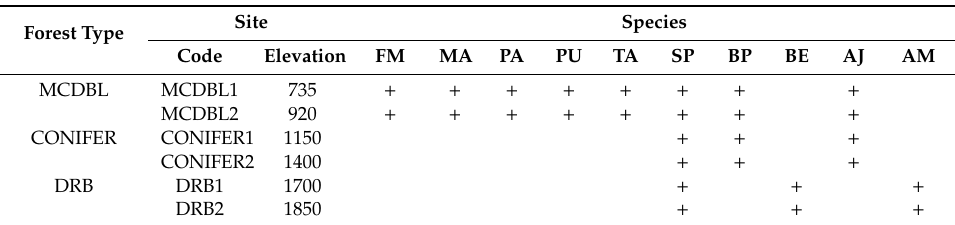
Table 2. The list of six sampling sites distributed in three forest types along the altitudinal gradient, showing the sampled species at each site. Species codes are given in Table 1. mixed conifer and deciduous broadleaf forests: MCB, dark conifer forests: CONIFER, dwarf rock birch forests: DRB. ’ + ’ refers to presence of that